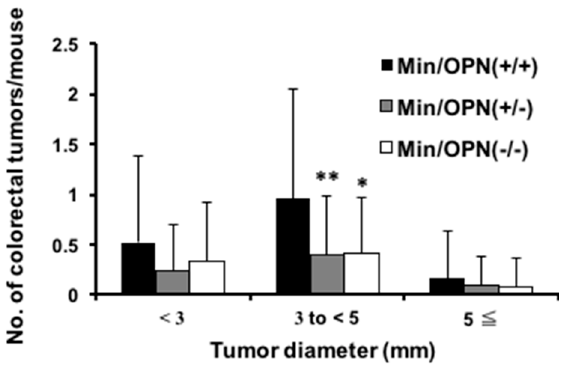
Figure 2. The effect of OPN deficiency on size distribution of colon tumors in Min mice. The number of tumors per mouse in each size class is given as a mean. Significant difference from Min/OPN(+/+) mice (* p < 0.05, ** p <